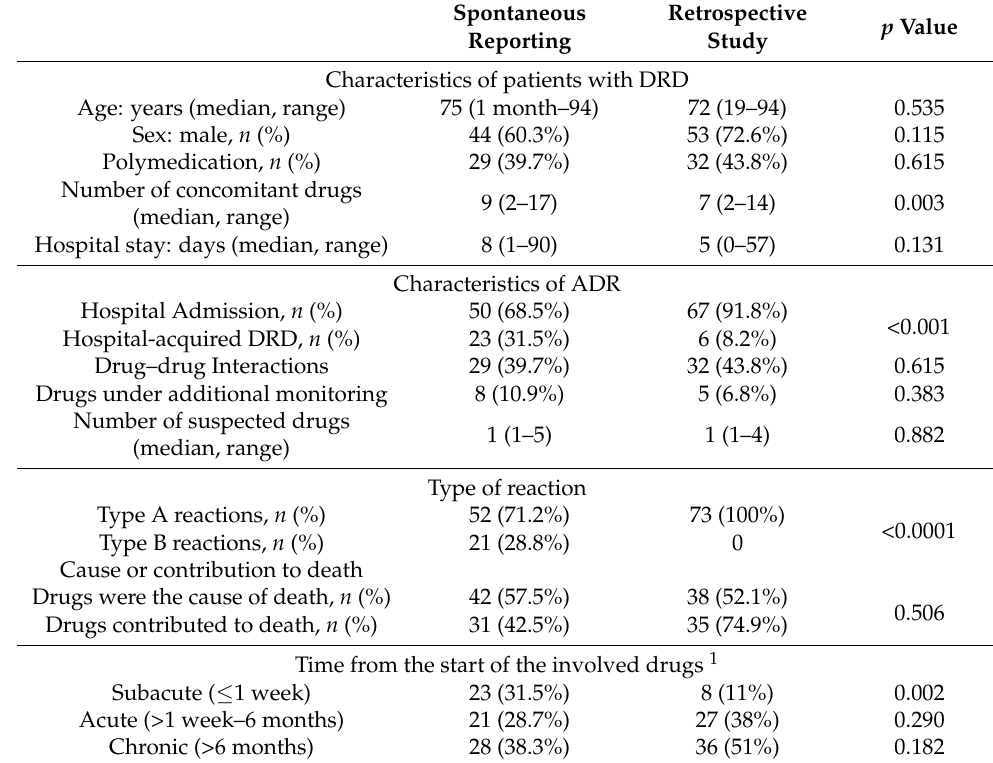
Table 9. Comparison of patients and DRD characteristics.